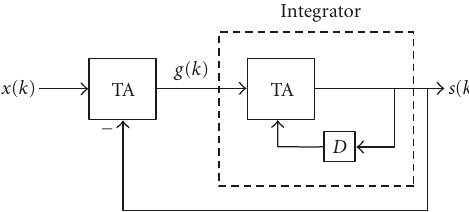
Figure 3: Realization of a first-order SDM using the proposed adder (TA) and the